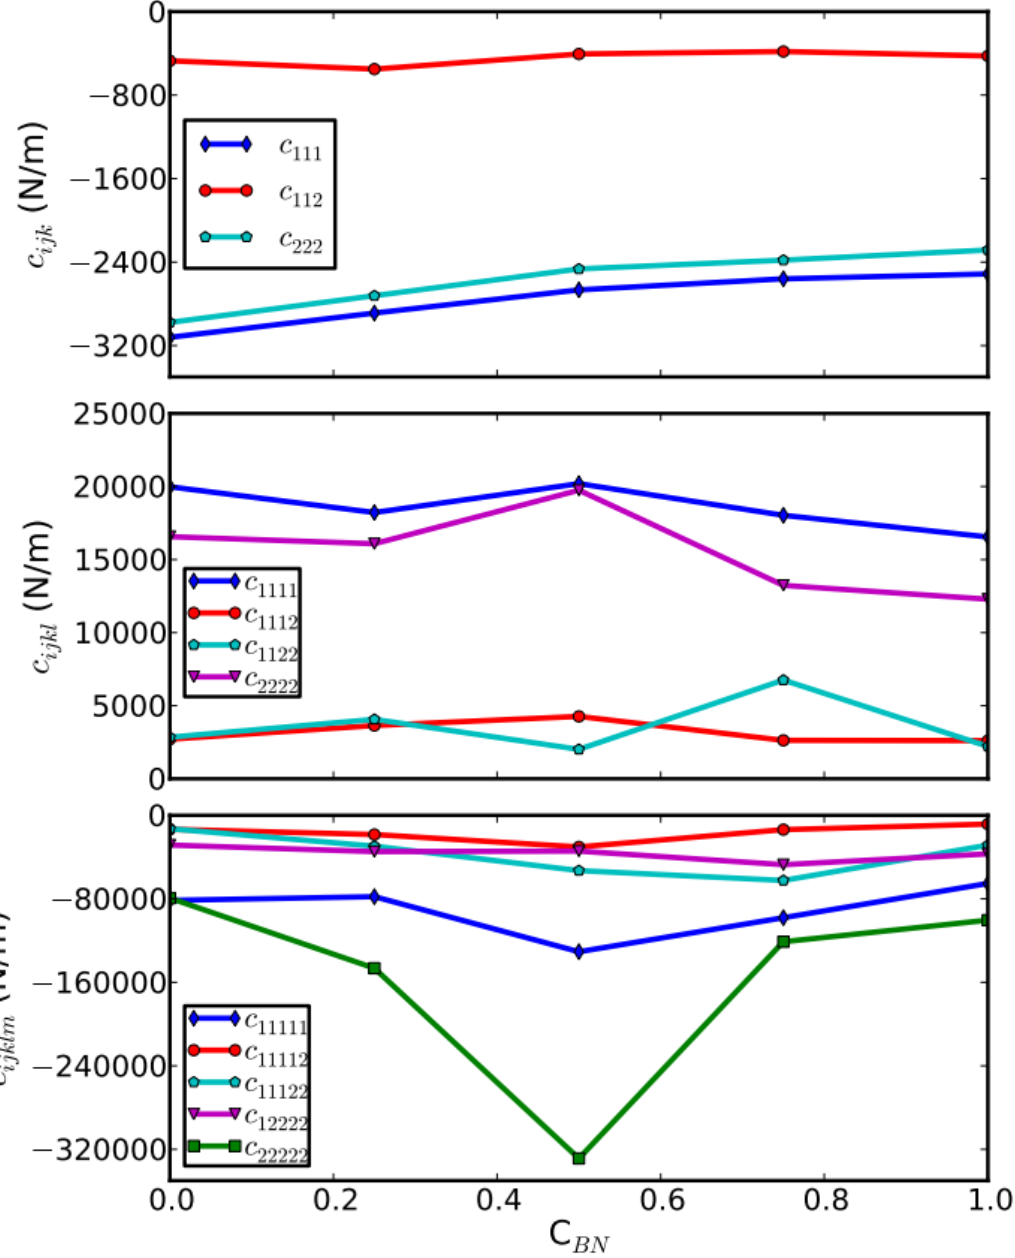
Figure 7. High-order elastic constants TOEC, FOEC, and FFOEC as a function of g -BN concentrations C BN.